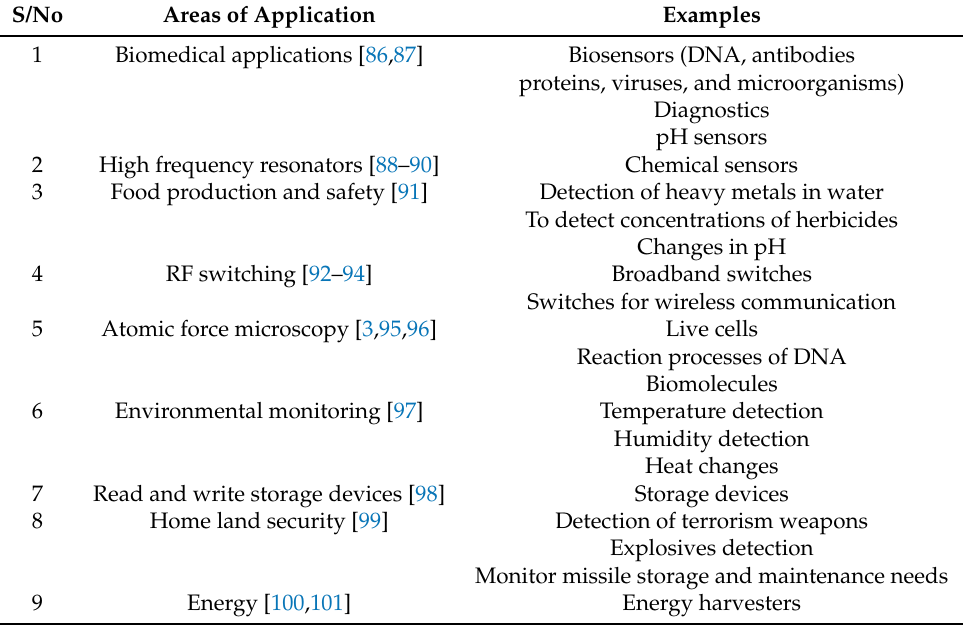
Table 1. Areas of applications for the